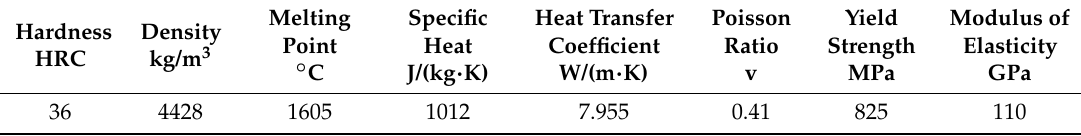
Table 1. Physical and mechanical properties of Ti6Al4V.